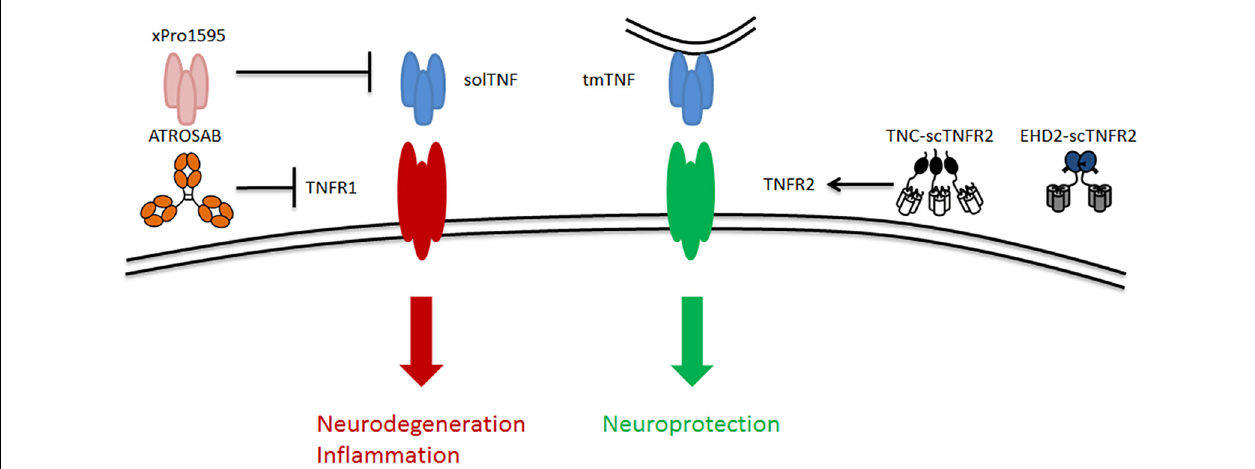
FIGURE 2 | Schematic of TNF signaling via its two receptors TNFR1 and TNFR2 as well as the existing potential therapeutic approaches targeting TNFR2, including solTNF inhibitor [e.g., xPro1595 (Olleros et al., 2010; Shi et al., 2011a)], TNFR1-specific antagonist [e.g., ATROSAB (Kim et al., 2016)], and TNFR2-specific agonists [e.g., TNF-scTNFR2 (Fischer et al., 2011) and EHD2-scTNFR2 (Dong et al., 2016)]. solTNF, soluble tumor necrosis factor; tmTNF, transmembrane tumor necrosis